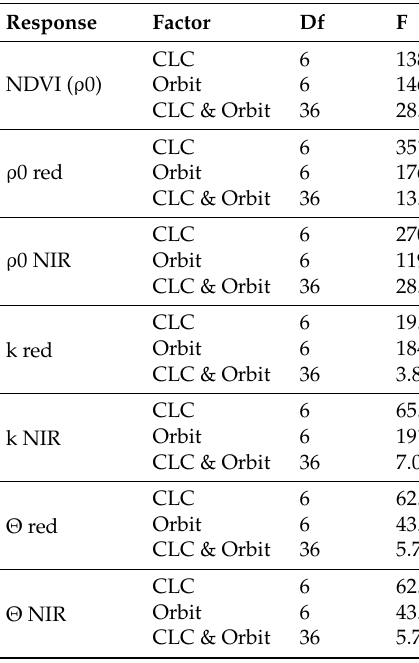
Table 6. Results from the linear multi-regression models and the ANOVA test (Df is the Degrees of freedom, F is the Fisher statistical value, lm refers to the linear model, * implying significance at p < 0.01 level).